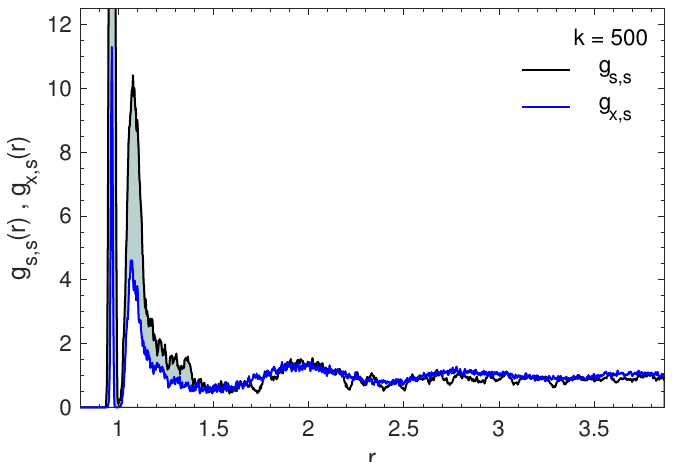
Figure 4. Radial distribution functions g x , s and g s , s . k = 500. The grey region emphasizes the tendency of a central soft monomer to be surrounded by more soft particles than a generic one in the first coordination